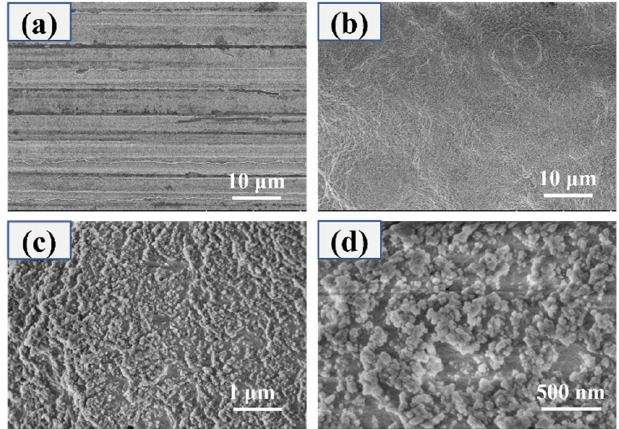
Figure 3. FESEM images of ( a ) the bare AZ31B Mg alloy and ( b – d ) the super-hydrophobic surface under magnifications.